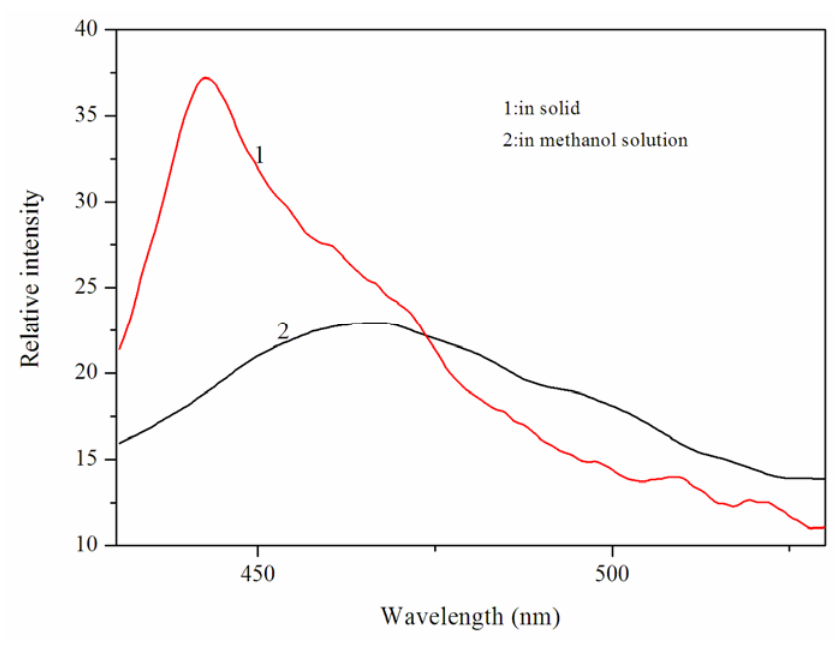
Figure 5. The emission spectrum of the Cd (II) complex. The excitation and emission slit widths were 5